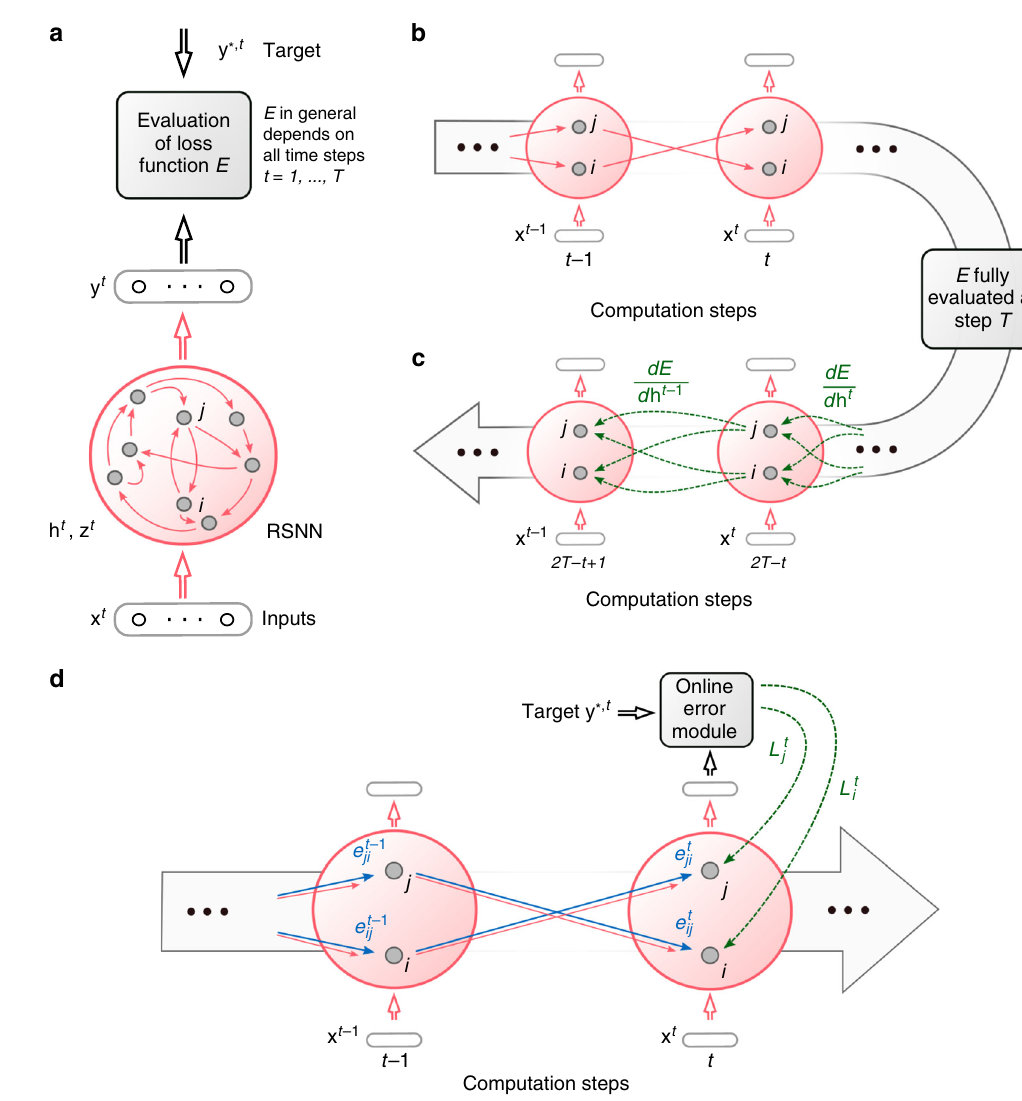
Fig. 1 Schemes for BPTT and e-prop. a RSNN with network inputs x , neuron spikes z , hidden neuron states h , and output targets y * , for each time step t of the RSNN computation. Output neurons y provide a low-pass fi lter of a weighted sum of network spikes z . b BPTT computes gradients in the unrolled version of the network. It has a new copy of the neurons of the RSNN for each time step t . A synaptic connection from neuron i to neuron j of the RSNN is replaced by an array of feedforward connections, one for each time step t , which goes from the copy of neuron i in the layer for time step t to a copy of neuron j in the layer for time step t + 1. All synapses in this array have the same weight: the weight of this synaptic connection in the RSNN. c Loss gradients of BPTT are propagated backwards in time and retrograde across synapses in an of fl ine manner, long after the forward computation has passed a layer. d Online learning dynamics of e-prop. Feedforward computation of eligibility traces is indicated in blue. These are combined with online learning signals according to Eq.